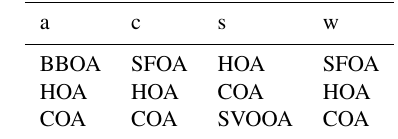
Table 1. Sets of target profiles used in the study.